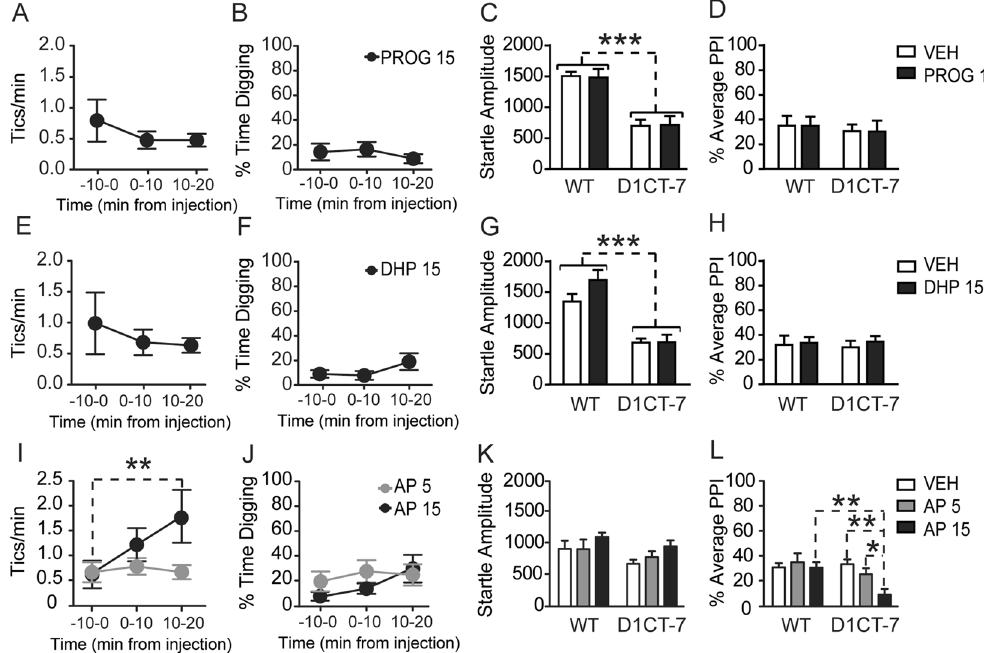
Figure 2. Effects of ( A–D ) progesterone (PROG), ( E–H ) 5 α -dihydroprogesterone (DHP) and ( I–L ) allopregnanolone (AP) on behavioral phenotypes related to Tourette syndrome. Data are shown as means ± SEM. * P < 0.05, ** P < 0.01 and *** P < 0.001 for comparisons indicated by dashed lines. Main effects for genotype are indicated as comparisons between brackets. Doses are indicated in mg/kg (IP). N =